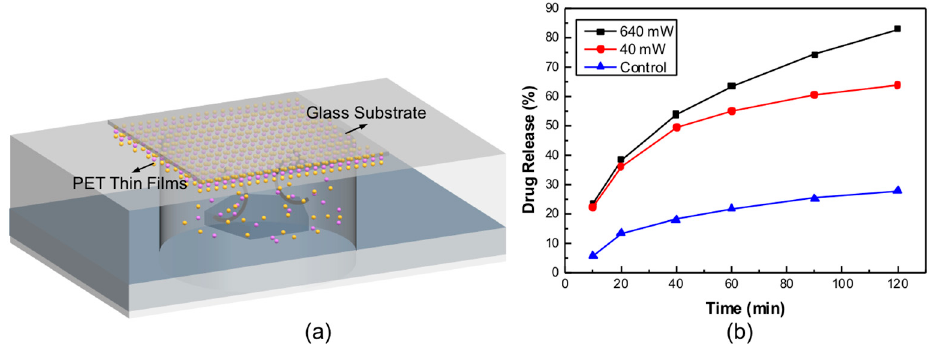
Figure 4. ( a ) Schematic of the release system where the PET thin films were coated on a piece of glass and fixed above the device 2 mm away; ( b ) DOX release with time under the stimulus of the resonator. The input power is 640 mW.